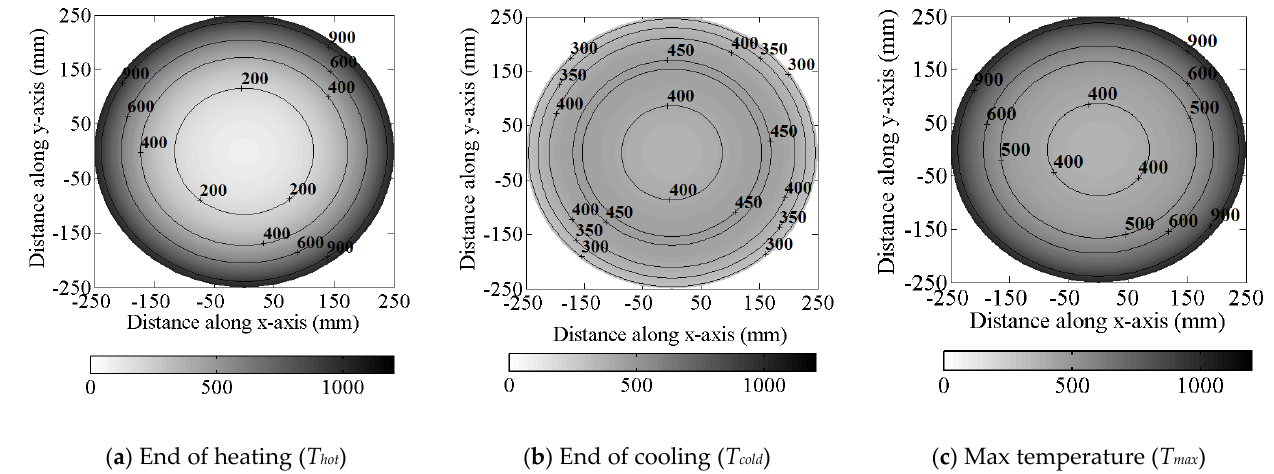
Figure 8. Temperature distribution within the circular cross-section of column (C3) at different time increments.